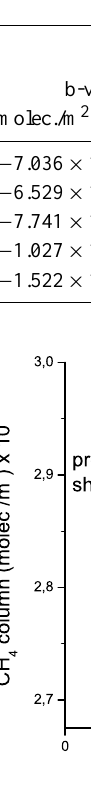
Table A4. Same as Table A3 but for normalised HF time series.